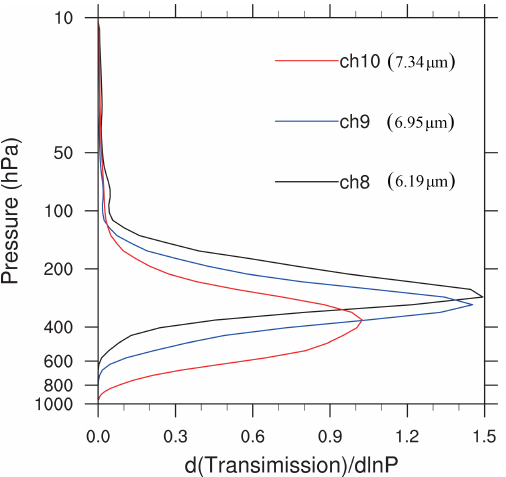
Figure 1. Weighting functions of the Himawari-8 Advanced Hi- mawari Imager’s three water vapor channels for channels